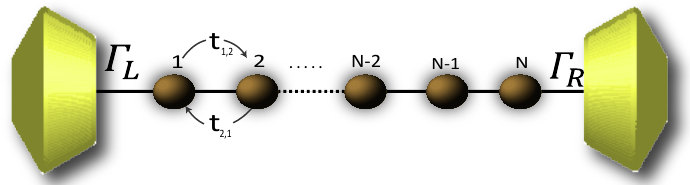
Figure 2. (Color online) Representation of the effective molecule coupled with the